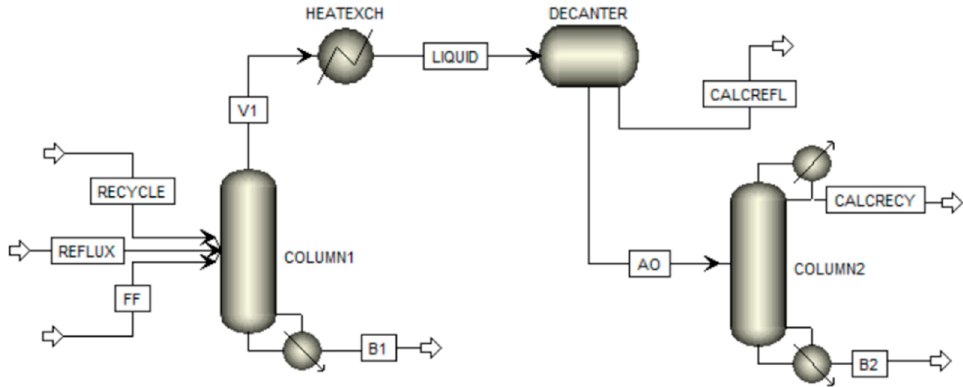
Figure 9. Flowsheet of the HAD process simulated in Aspen Plus ® V11 [61] for the separation of the mixture 2-propanol + water using isooctane as an entrainer (with the two loops related to the recycle streams not closed).